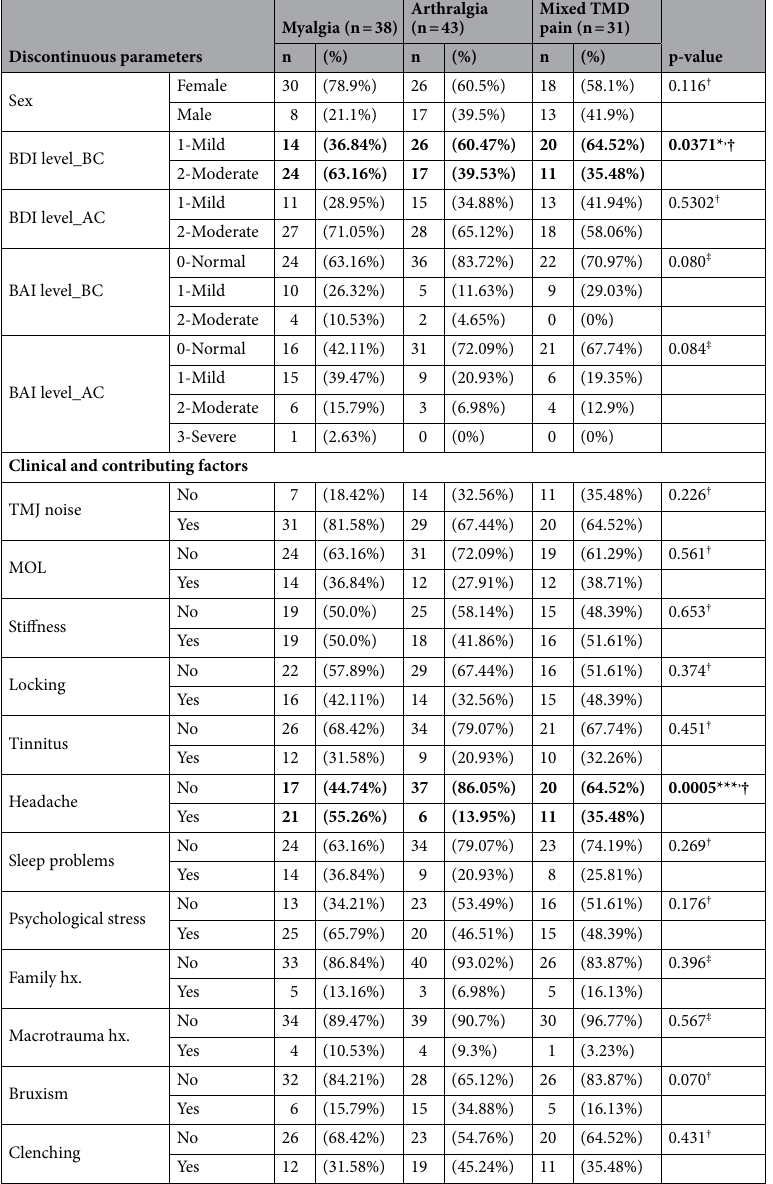
Table 2. Comparison of discontinuous parameters before and after COVID-19. TMD: temporomandibular disorder, MOL: mouth-opening limitation, BDI: Beck Depression Inventory, BAI: Beck Anxiety